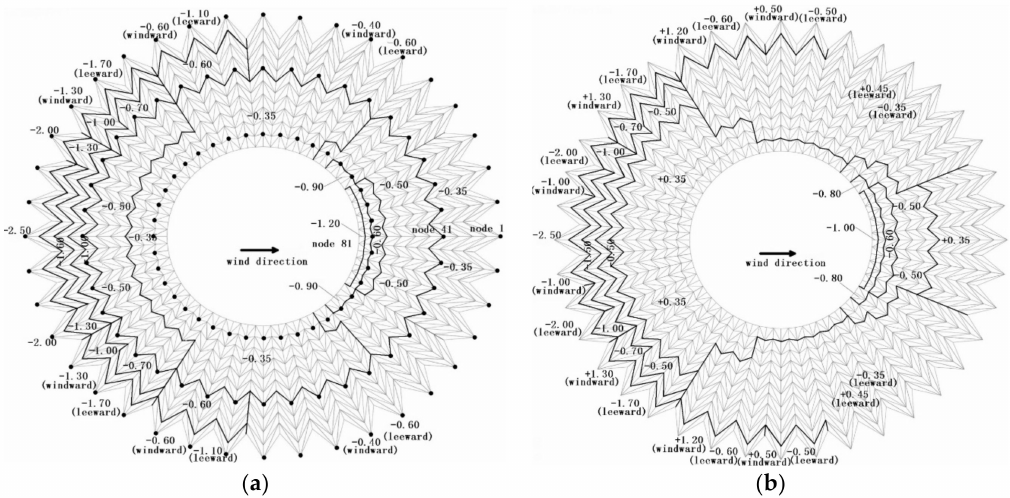
Figure 5. Wind pressure distribution. ( a ) Wind pressure distribution of the symmetric wind; ( b ) Wind pressure distribution of the asymmetric